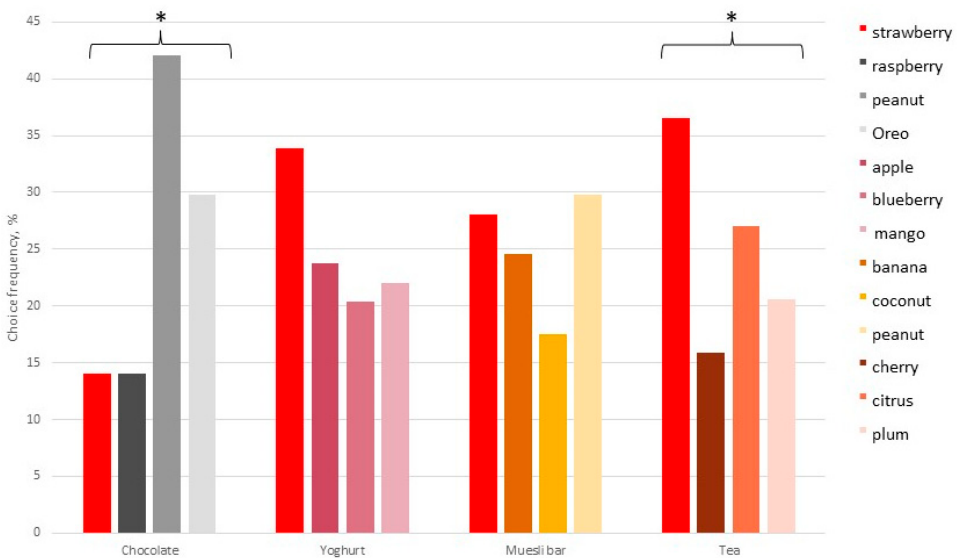
Figure 2. Frequency of choice for all four choice sets with each four alternatives. * indicates a significant effect at a level of p < 0.05. Product categories had different flavors; only the strawberry flavor was common, which is colored in red. Table 2. Repeated measures ANOVA presenting the F-values of the three main effects and two of their interactions for the four product